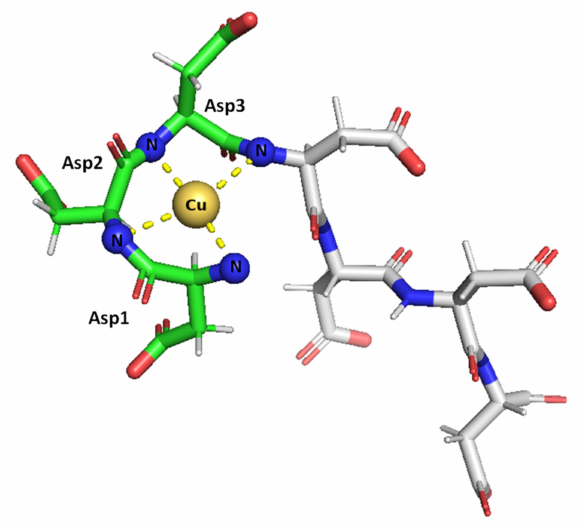
Figure 8. Suggested mode of coordination for Cu(II)-SAAP3 at pH 9. Cu(II) is bound by the N-terminal amine and three amide nitrogens, giving square-planar coordination. Figures were generated using PyMOL